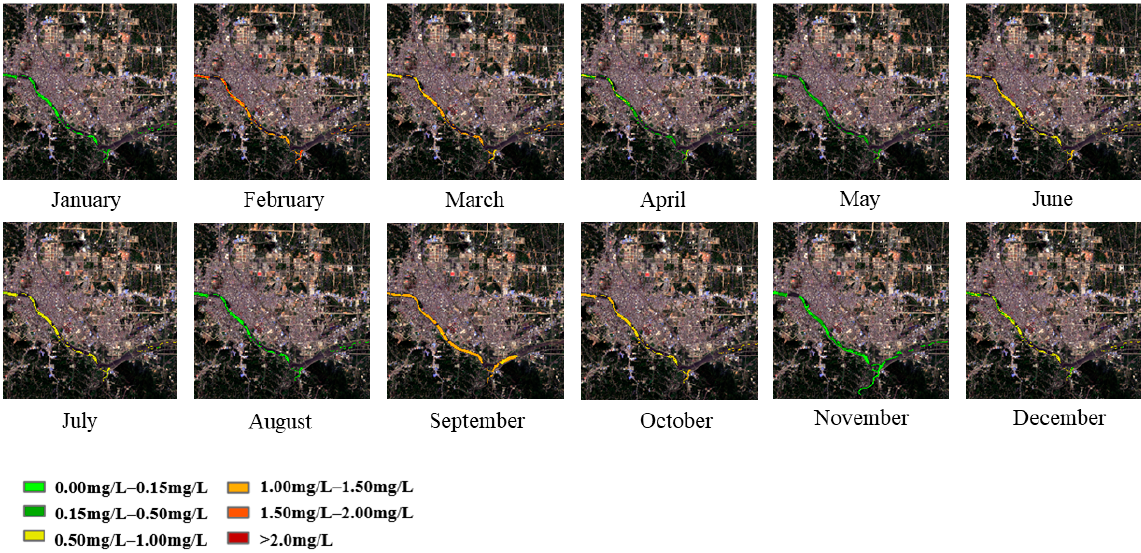
Figure 11. Region (a) monthly NH 3 -N concentration variations.